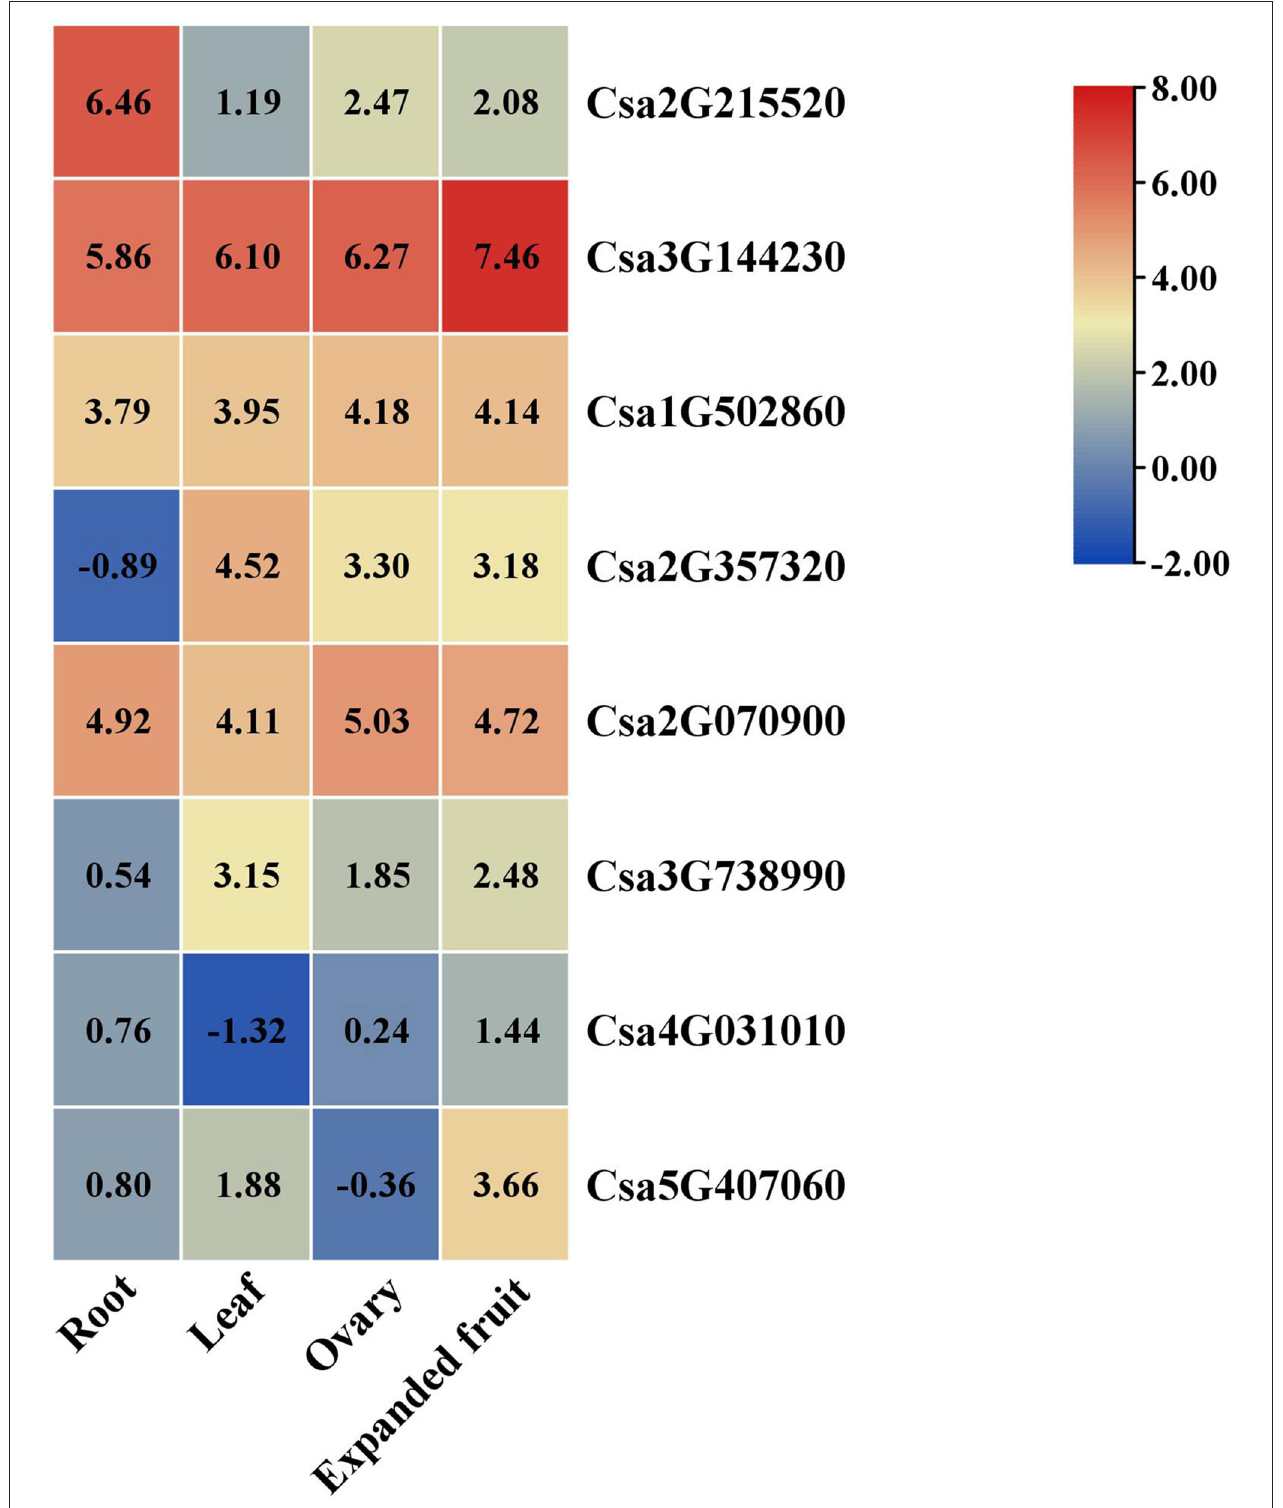
FIGURE 5 | Expression patterns of the target genes in the different tissues (root, leaf, ovary, and expanded fruit). The reads per kilobase of exon per million reads mapped (RPKM) values of these target genes were performed by log2. Differences in gene expression were shown by color. The red and blue colors represent the higher and lower relative expressions of the transcript,